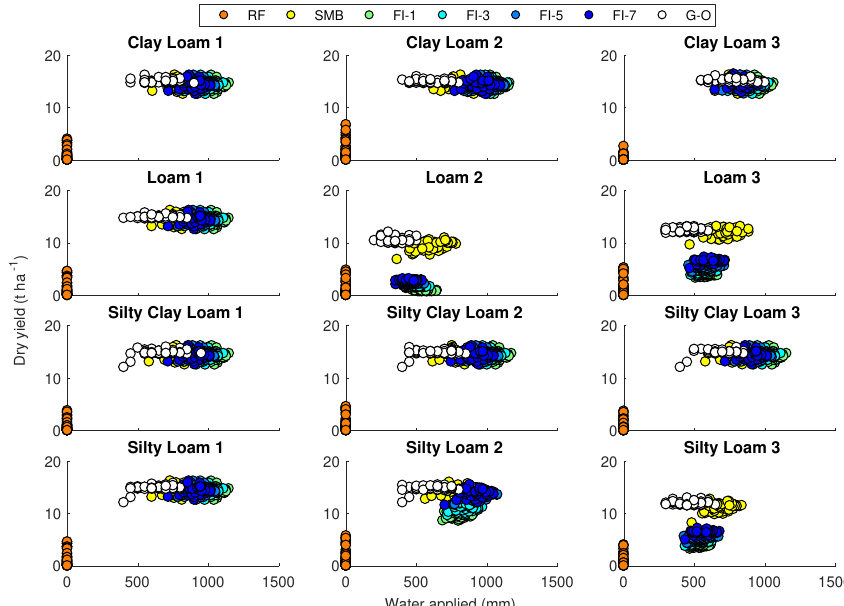
Figure 5. Dry yield as a function of water use for sugar beet for soils with low (1), medium (2), and high (3) bulk densities under different irrigation strategies: RF: Rainfed; SMB: Soil moisture-based; FI: Fixed interval every 1, 3, 5, and 7 days; and G-O: GET-OPTIS considering simulated values from 1965 to